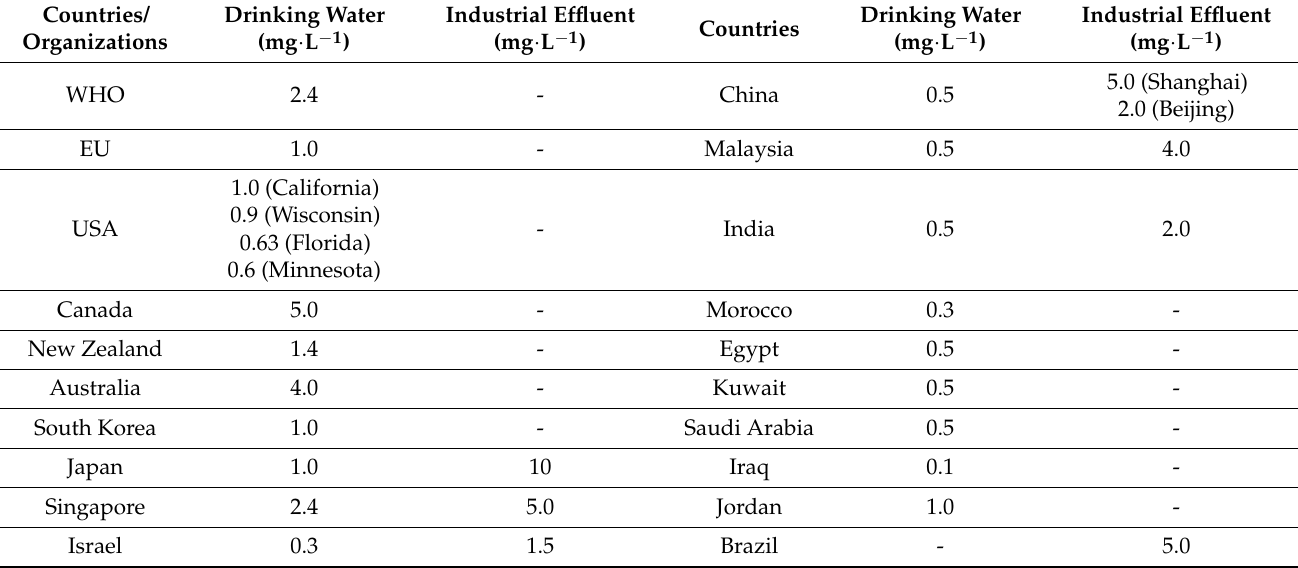
Table 5. The guideline values of boron in drinking water or industrial effluents suggested by different countries or organizations (Adapted with permission from Refs. [2,30,31]. 2021, Elsevier; 2014, CNKI; 2021,